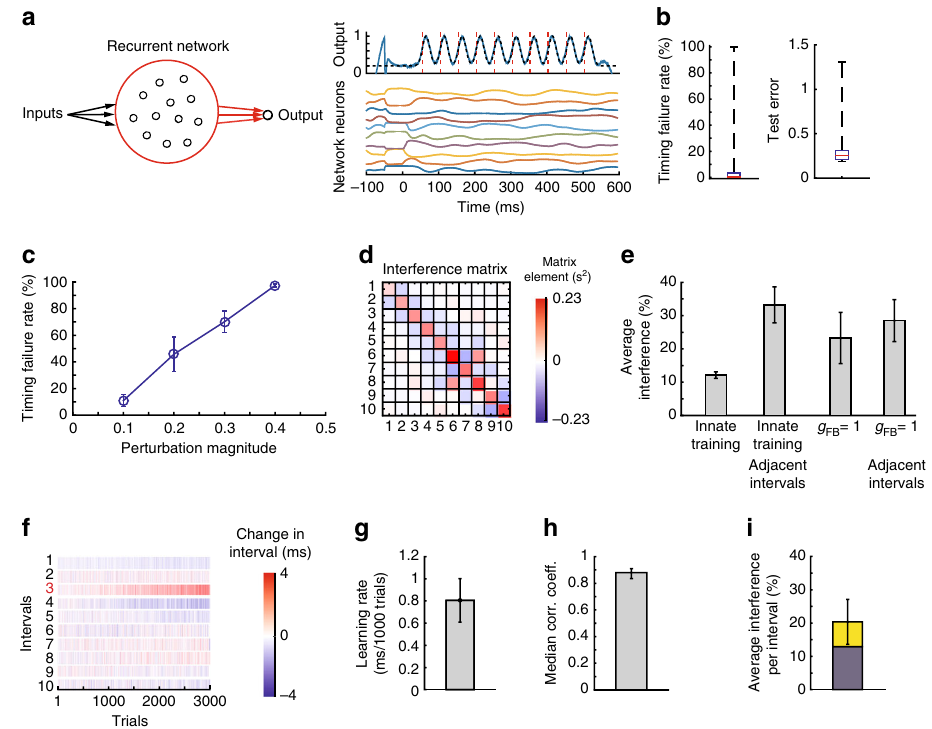
Fig. 3 Flexible timing with dynamic attractor networks. a Schematic showing the network architecture. Recurrent connections as well as the connections to the output neuron are trained. On the right are the activities of example neurons from the pattern generator network and the output neuron. b Box plots of training (test error, Methods) and timing (timing failure rate out of 400 trials) performances of 20 trained networks. Whiskers show maxima and minima; 14 out of 20 networks were successfully trained and used for the subsequent analysis in this fi gure. c Timing failure rates (out of 400 trials) for the network when perturbed by a pulse input of varying magnitude. d Example interference matrix. e Relative change in the duration of non-targeted intervals as a function of the change in targeted intervals ( ‘ average interference ’ ), calculated from the off-diagonal elements of the interference matrix, as in Fig. 2f except that the 1st interval is also taken into account. The average interference is compared to the interference in intervals adjacent to the target, and for fsRNNs with g FB = 1. f Example of a reinforcement learning ‘ experiment ’ that targeted interval 3 for lengthening. Shown is the effect on all intervals after for 3000 trials. g Learning rate averaged across networks as in Fig. 2i. h Median correlation coef fi cient between the interval changes calculated from the interference matrix and from the reinforcement learning simulations (as in Fig. 2i). Error bars denote 25th and 75th percentiles, respectively. i Average interference in reinforcement learning simulations as in Fig. 2k. The blue portion of the bars show the average interference calculated from the interference